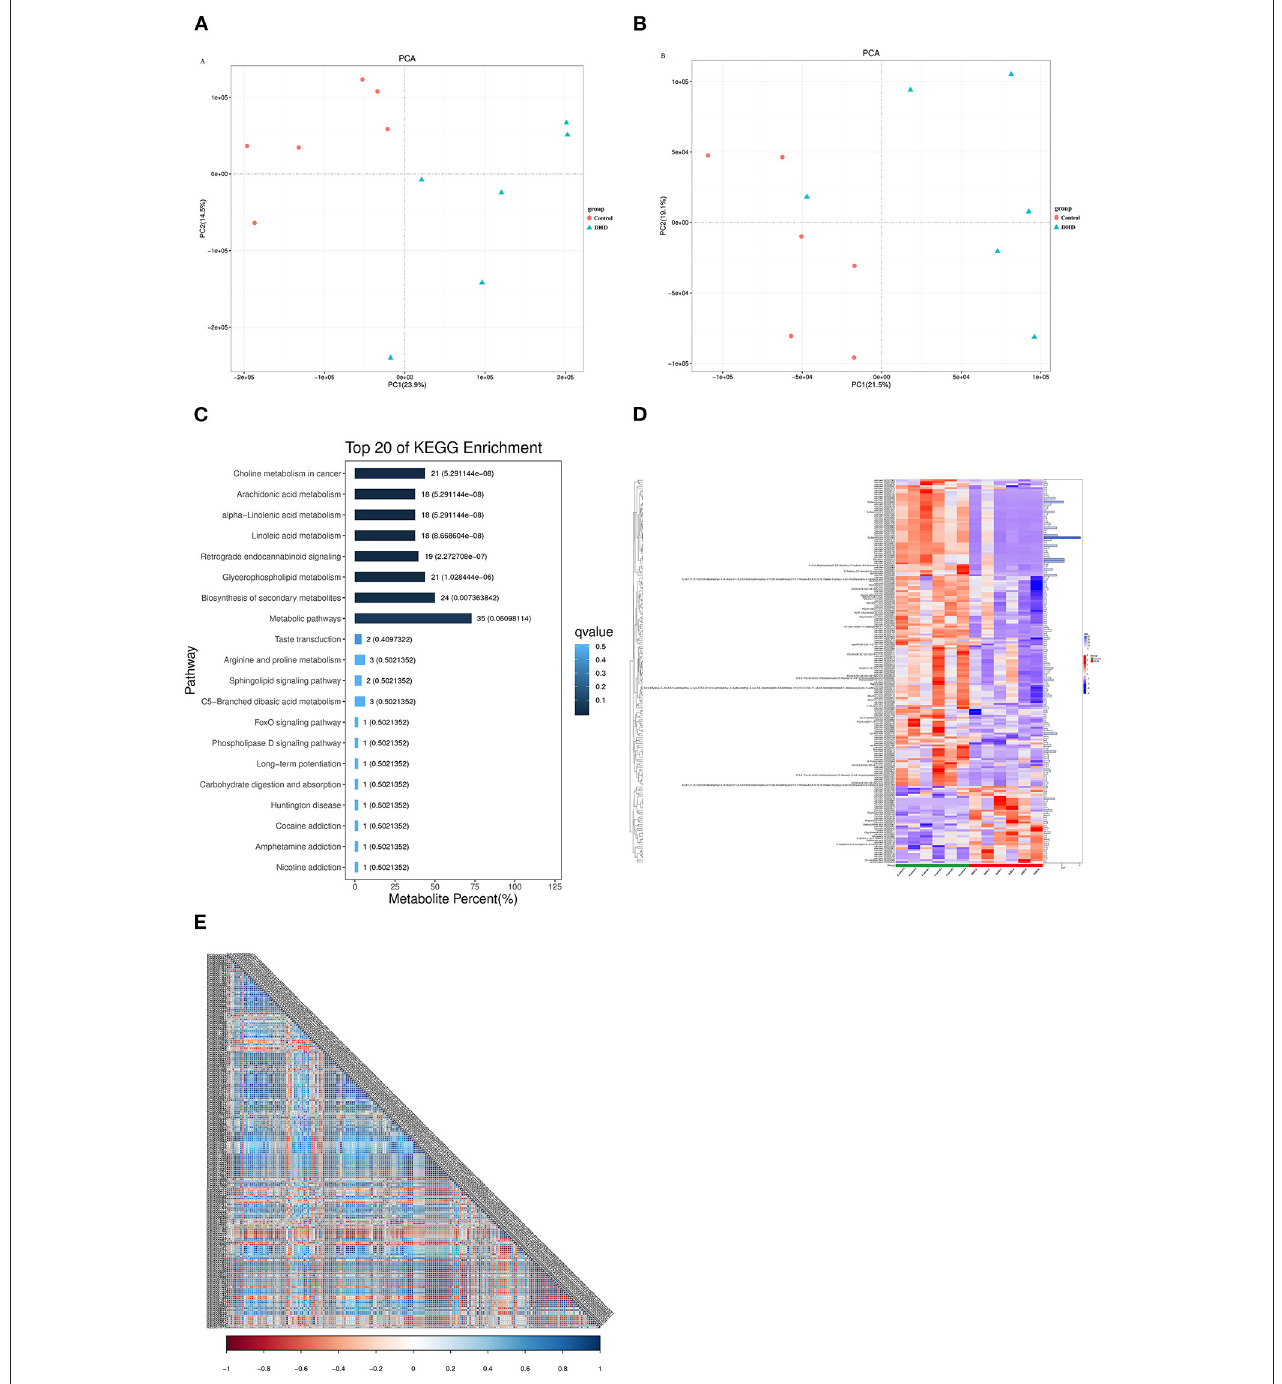
FIGURE 4 | Plasma metabolic profiles in DHD and control calves. PCA score of plasma metabolite analysis between DHD calves and healthy calves in (A) positive ion mode and (B) negative ion mode. (C) Results of the KEGG pathway enrichment analysis of significantly different metabolites (top 20). The horizontal axis represents the percentage of the number of metabolites in this pathway to the total number of significantly different metabolites, and the value on the histogram is the number of differential metabolites in this pathway and the Q value. (D) Significant differences in metabolites between DHD calves and control calves are shown in the hierarchical clustering and heat map on the left (columns, individual; rows, specific metabolite). The histogram on the right represents the VIP score for each metabolite derived from the OPLS-DA model. (E) Correlation coefficient matrix thermograph illustrating the functional correlation between the significantly altered metabolites in plasma. The correlation coefficient is expressed by color, blue is positive correlation and red is negative correlation. The darker the color, the stronger the correlation.